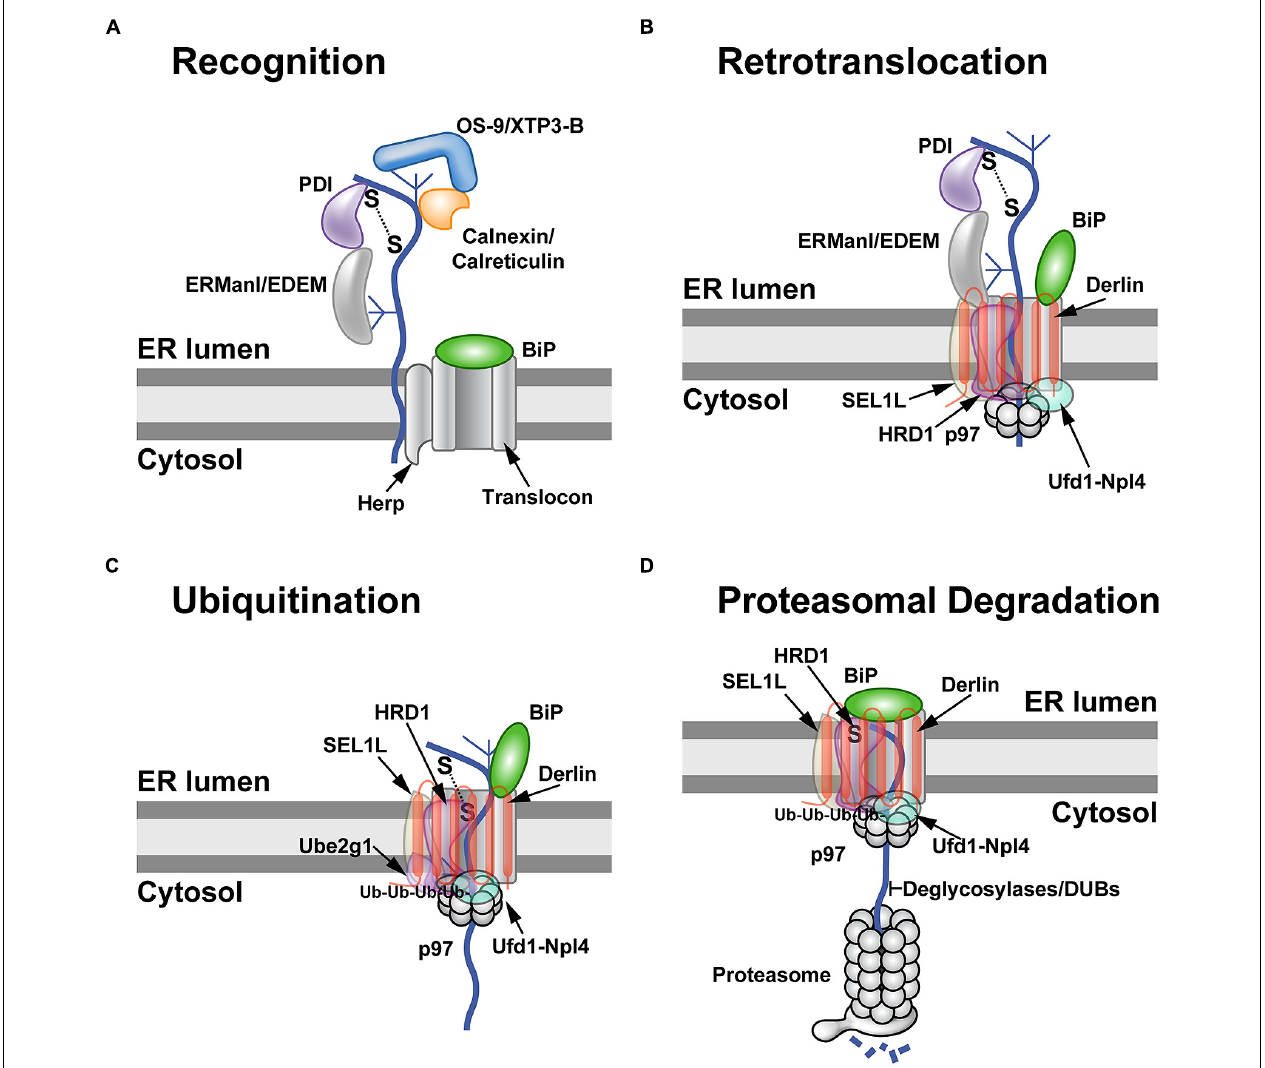
FIGURE 1 |The ERAD process. (A) Substrate recognition. Many nascent polypeptides (curved line) have one or more high-mannose carbohydrates (shown as a branched structure), which must be recognized and processed in a timely manner to allow exit from the ER. Binding of these ER-luminal proteins to substrates is affected by folding to their native conformations. Folding involves formation and breakage of disulfide bonds by members of the PDI family, such as ERp57 and ERp72, and is facilitated by chaperone proteins, such as BiP. Specific carbohydrates are bound by different chaperones/lectins in the ER lumen.These proteins include ERManI, EDEM, OS-9, XTP3-B, calreticulin, and calnexin. Recognition of ERAD substrates probably results in assembly of the retrotranslocon (shown here as Herp and the translocon/BiP complex). Herp is thought to facilitate oligomerization of the Hrd1 E3 ligase. BiP binds to a number of glycosylated and non-glycosylated ERAD substrates and provides a barrier on the ER luminal side of the translocon. (B) Retrotranslocation. Recognition of misfolded or misassembled proteins triggers the assembly of the retrotranslocon. Current evidence indicates that multiple types of retrotranslocons are possible (see text). A typical retrotranslocon/dislocon is shown containing Derlin, the E3 ligase Hrd1 and its partner Sel1L, which then recruits the cytosolic ATPase p97. Derlin has 6 transmembrane domains with both the N-terminus and